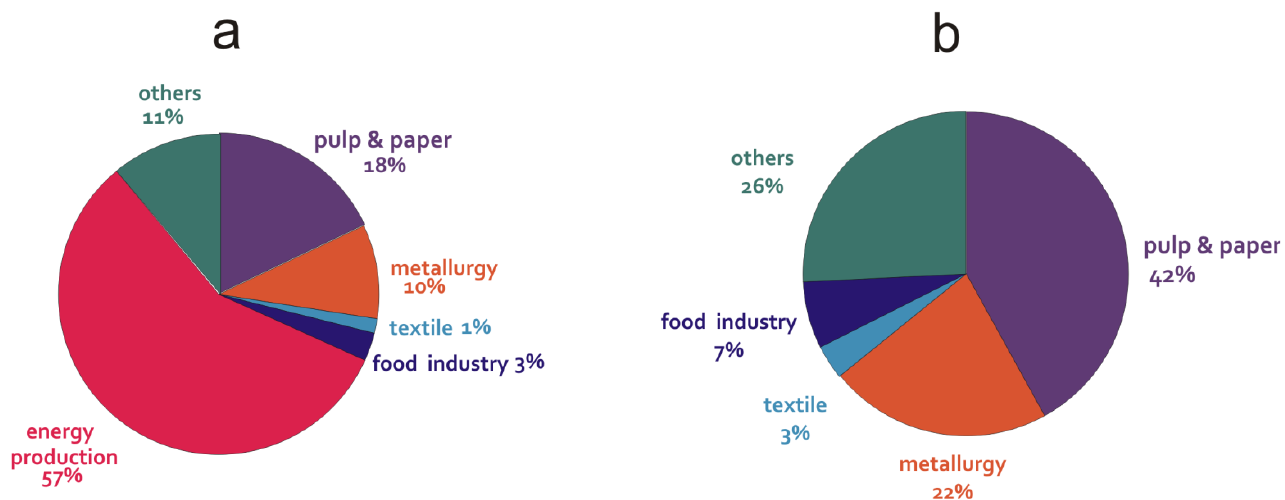
Figure 3. Global ( a ) industrial wastewater production and ( b ) manufacturing industry wastewater. The estimations are based on the statistical data of water use and production volume for various industrial sectors. Table 1. Global municipal and industrial wastewater production for selected sectors.